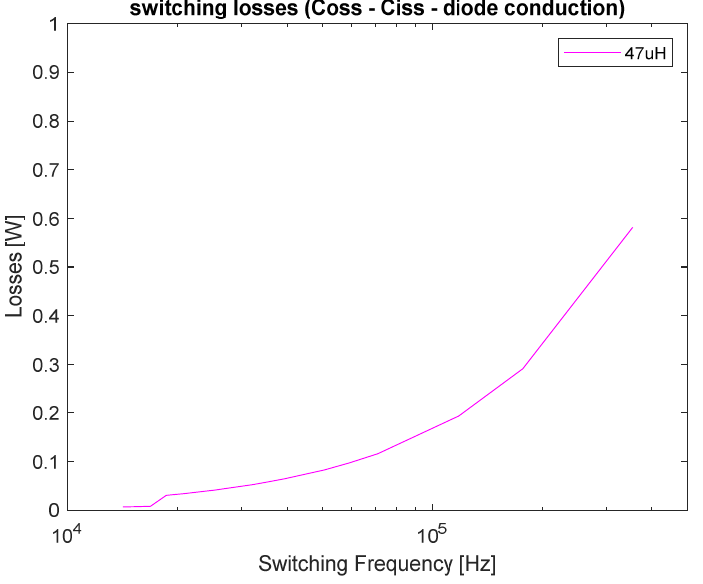
Figure 16. Switching losses made by the four transistors depending on the switching frequency in a converter using two 47 uH main inductors.